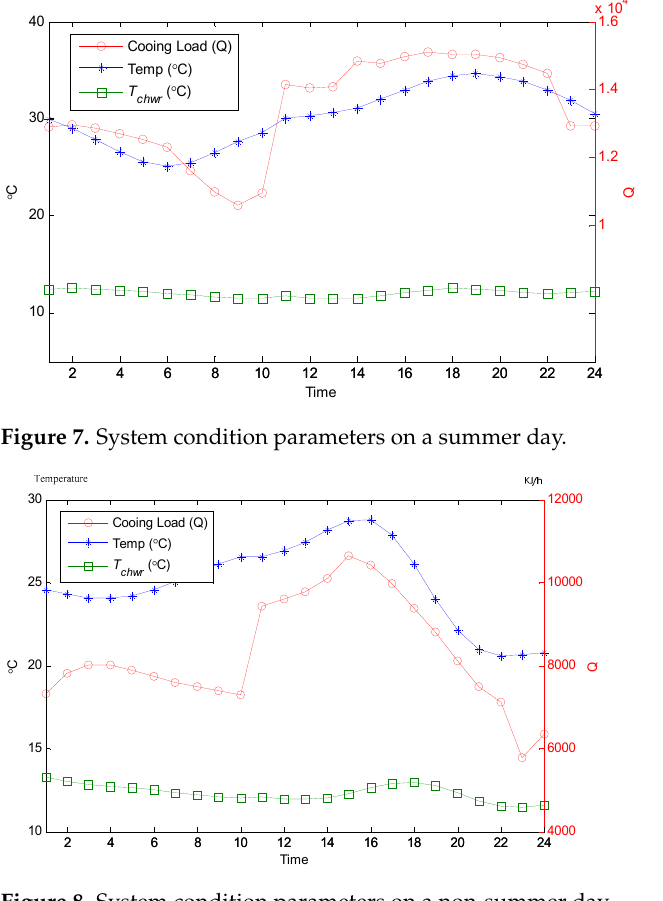
Figure 8. System condition parameters on a non-summer day.